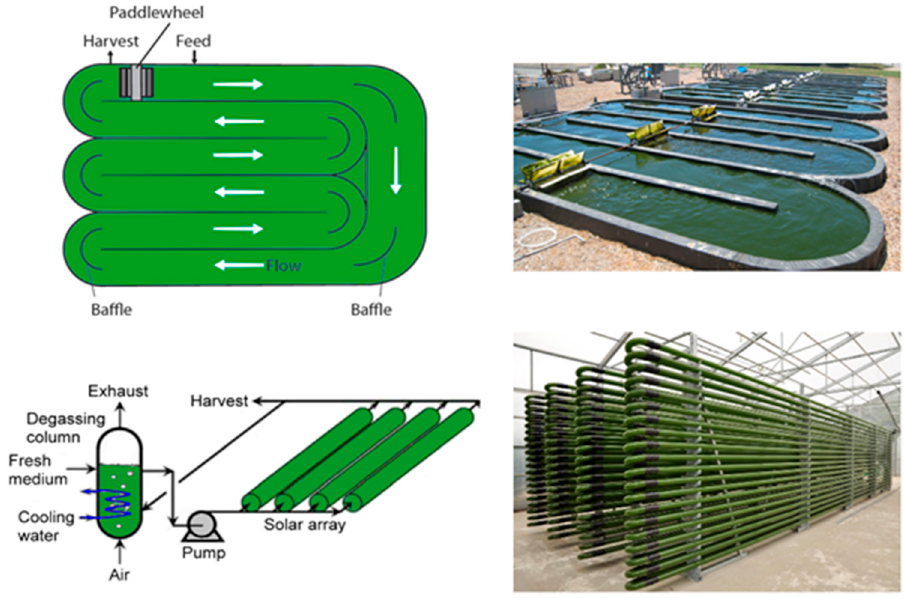
Figure 3. Schematic ( left ) and photographs ( right ) of ORP ( top panels ) and PBR ( bottom panels ). Adapted, with permission, from Biotechnology Advances 2007, 25,